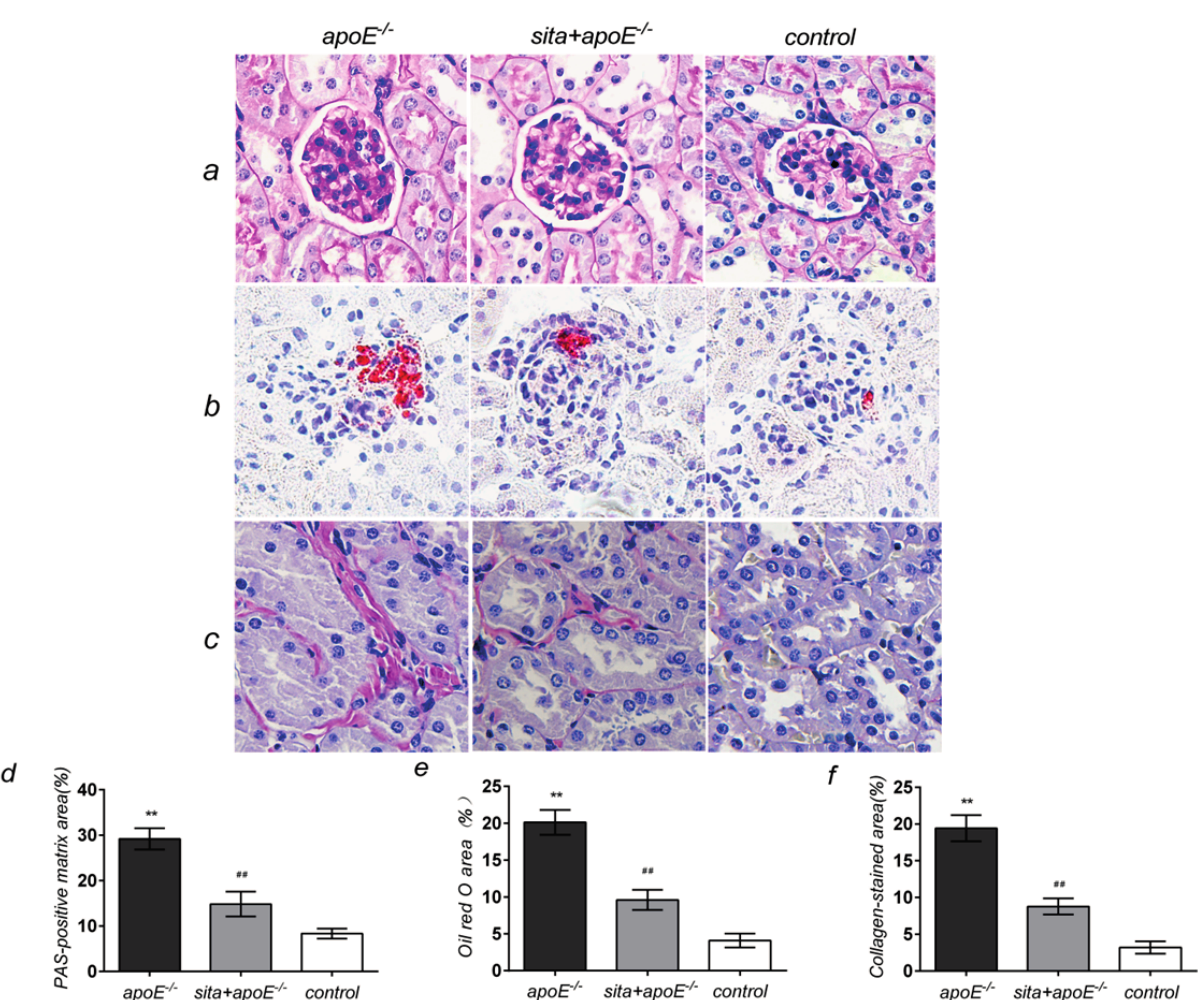
Figure 3. Effect of sitagliptin on dyslipidemia-induced pathological changes of the